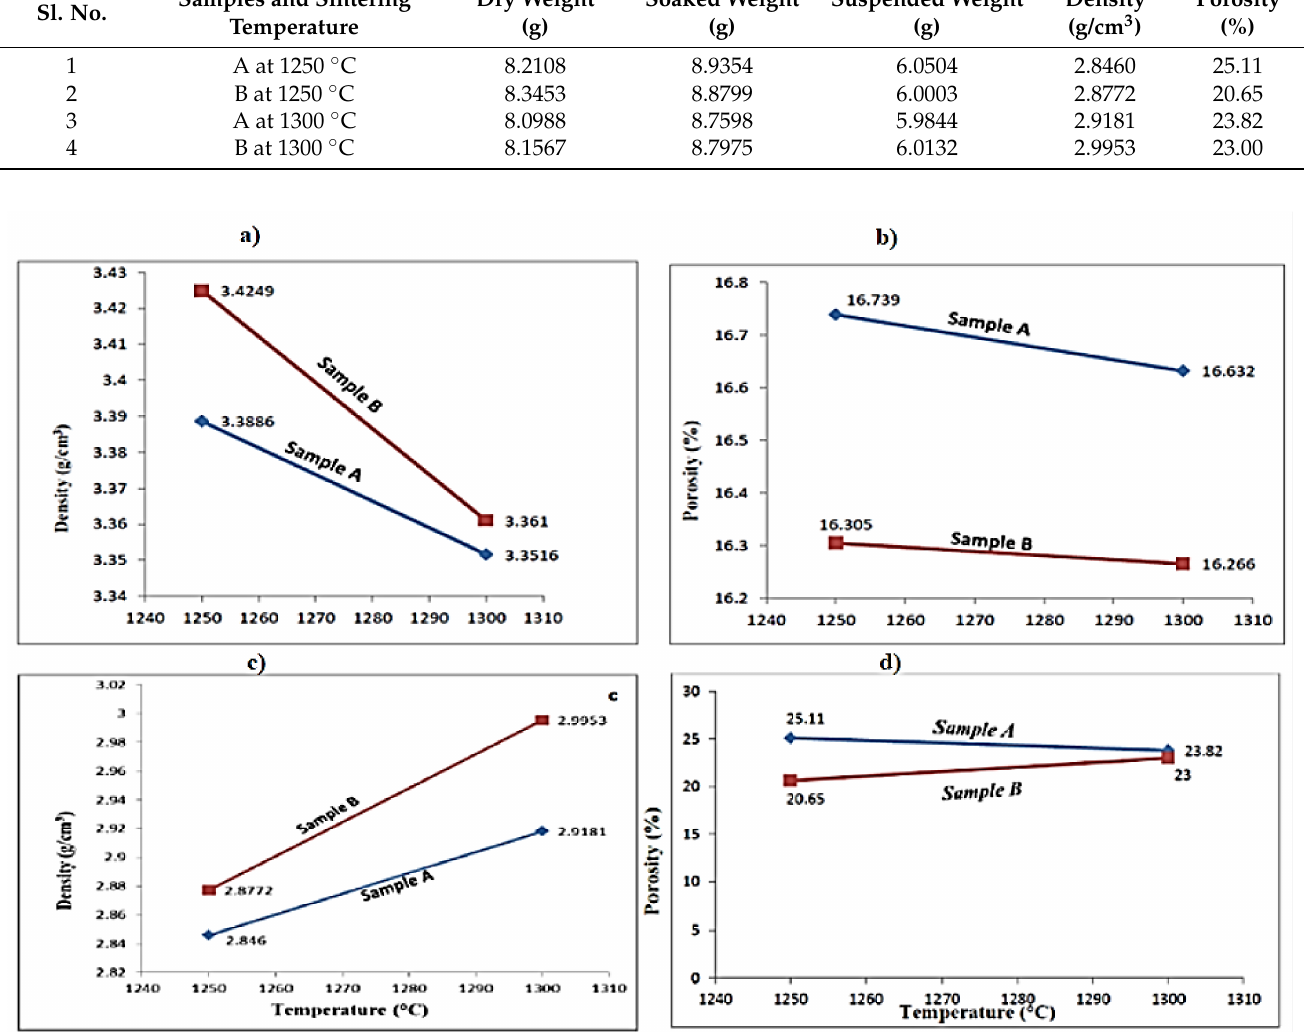
Figure 13. ( a ) Density and ( b ) porosity of microwave sintered samples; ( c ) density, and ( d ) porosity of conventionally sintered